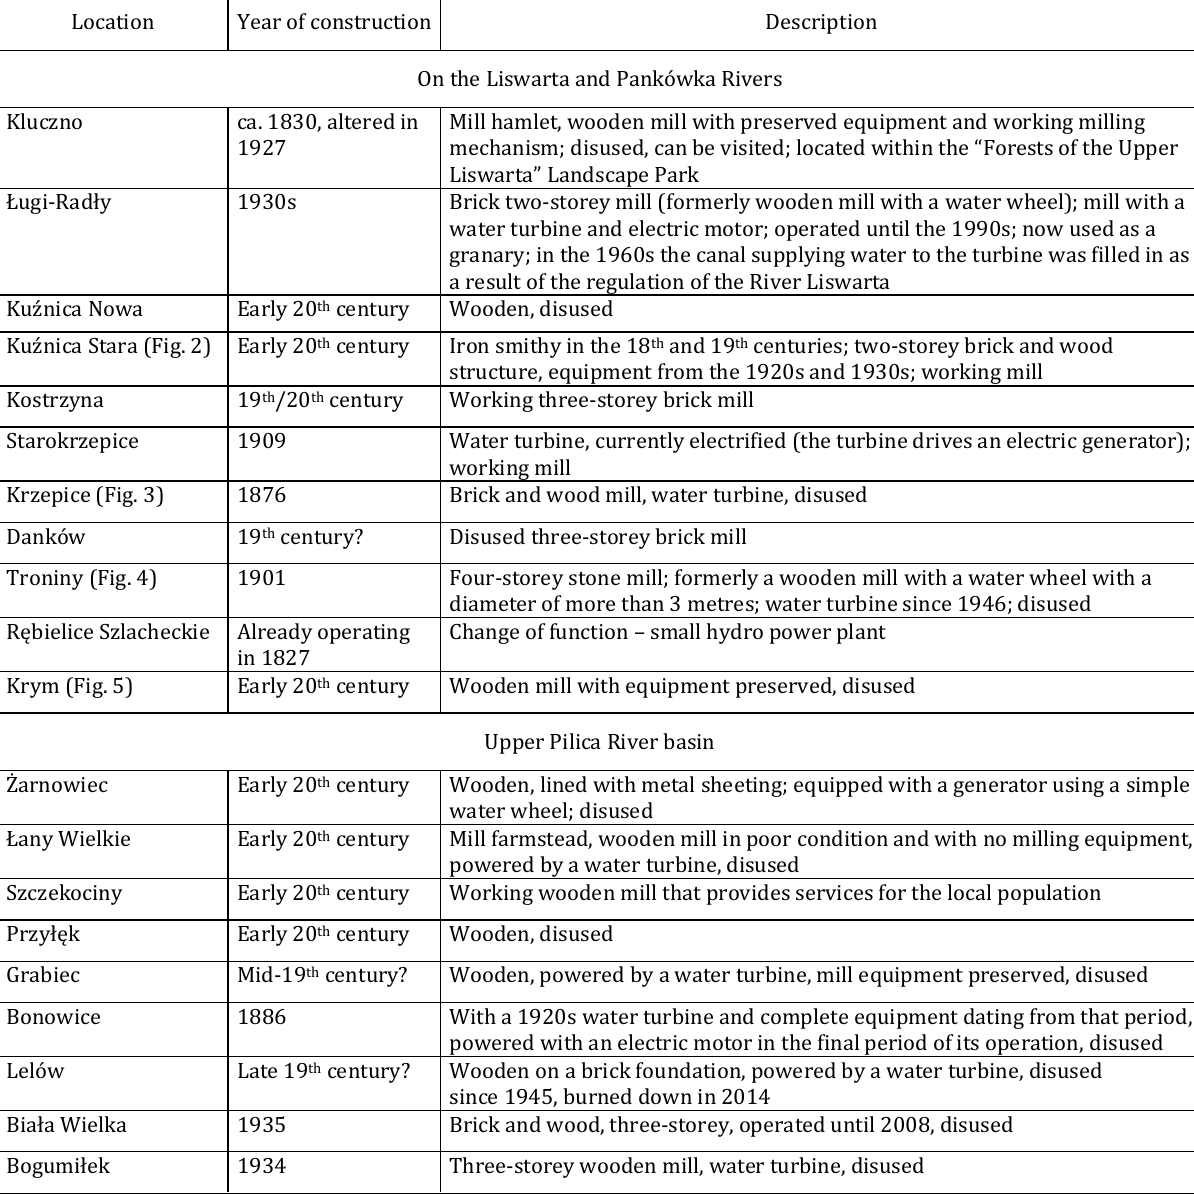
Table 1. Watermills in the Liswarta and upper Pilica River basins – selected examples (source: own research based on online sources: http://www.nid.pl, http://www.polskaniezwykla.pl,